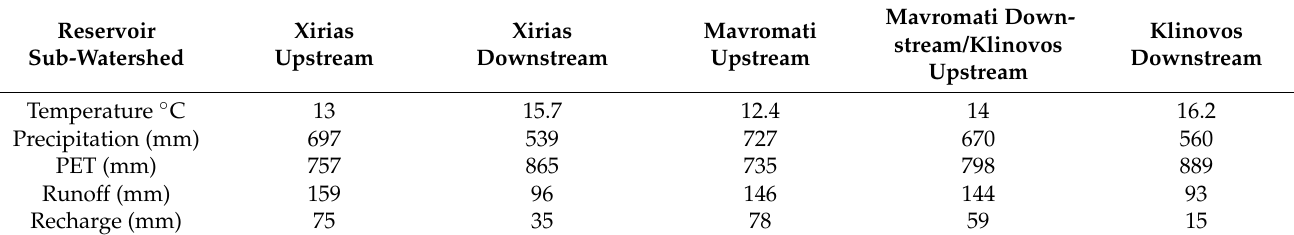
Table 5. Mean annual values of input meteorological data and simulated results of the UTHBAL model for the reservoir sub-watersheds of Almyros basin.